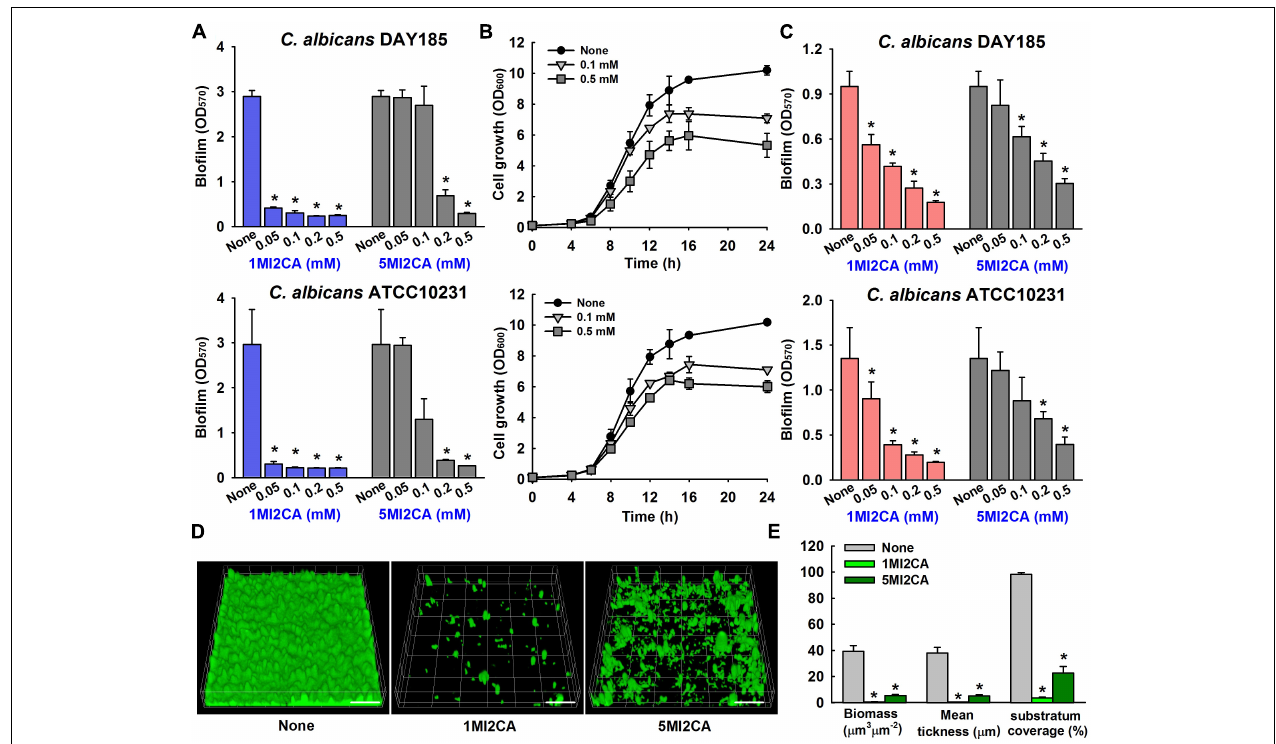
FIGURE 2 | Effect of methylindoles on C. albicans biofilm formation and cell growth. The anti-biofilm activities of 1-methylindole-2-carboxylic acid (1MI2CA) and 5-methylindole-2-carboxylic acid (5MI2CA) were examined against C. albicans DAY185 and C. albicans ATCC10231 in PDB medium (A) and YPD medium (C) after incubation for 24 h. At least two independent experiments were conducted (six wells per sample). Planktonic cell growths of C. albicans DAY185 after incubation with 1MI2CA or 5MI2CA at their biofilm inhibitory concentrations of 0.1 and 0.5 mM for 24 h (B) . Confocal laser scanning microscopic observations of the effects of methylindoles on C. albicans biofilms (D) . Biofilm formation by C. albicans on polystyrene plates was observed in the presence of 1MI2CA or 5MI2CA at 0.1 mM by confocal laser microscopy. Scale bars represent 100 µ m. Biofilm formation was quantified using COMSTAT (E) . Two independent experiments were conducted (six wells per sample). Error bars indicate standard deviations. ∗ p < 0.05 vs. untreated controls.